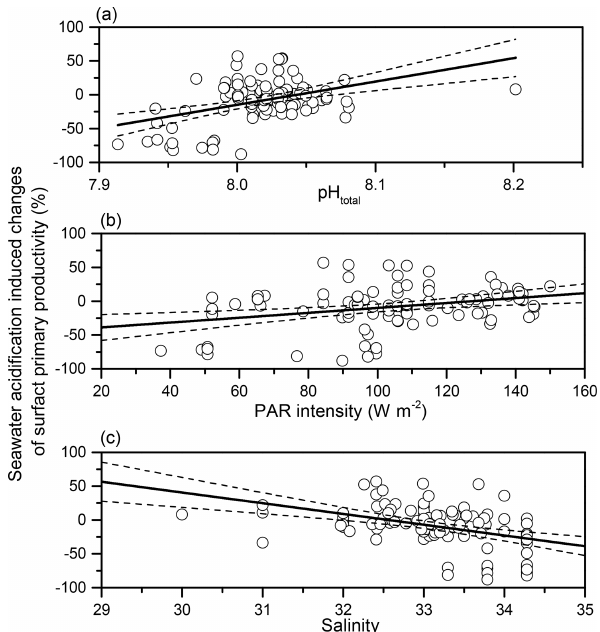
Figure 6. Seawater-acidification-induced (pH decreases of 0.4 units) changes on surface primary productivity (%) in the Taiwan Strait and the South China Sea as a function of ambient pH total (a) , PAR (b) , and salinity (c) . The dotted lines represent 95% confidence